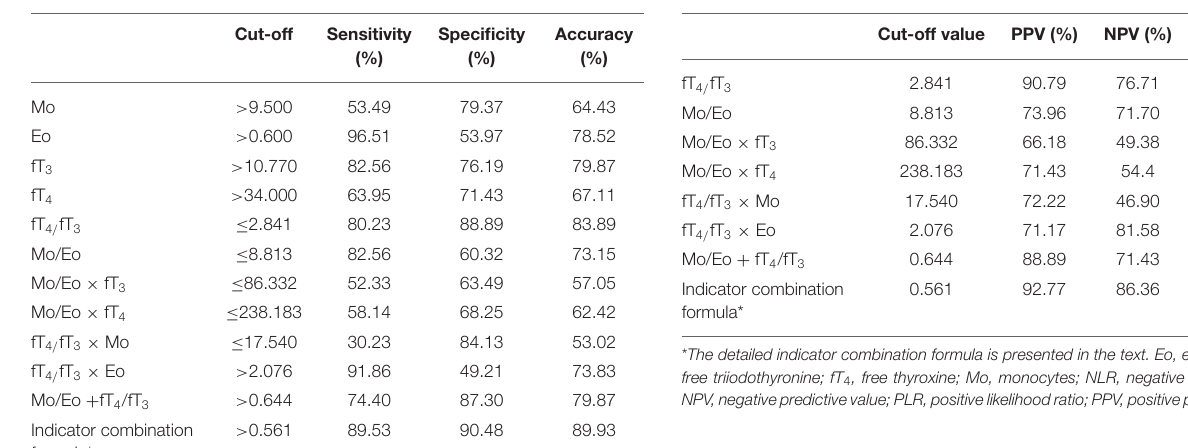
TABLE 4 | Positive value and likelihood ratio of cut-off levels of various indexes in untreated Graves’